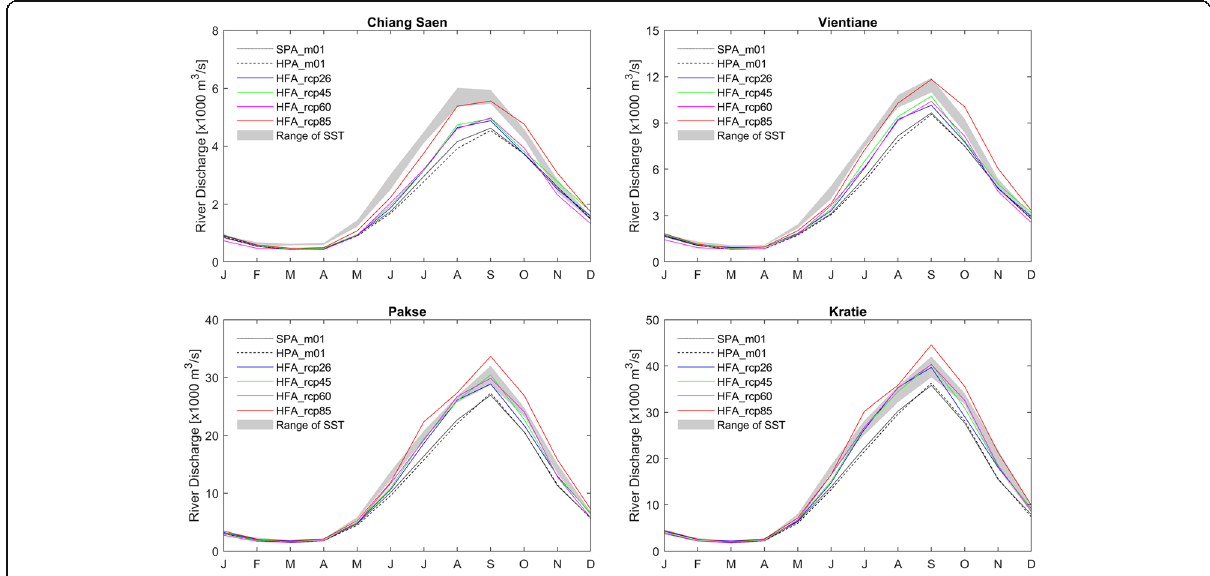
Fig. 6 Average monthly discharge of present and projected future climate experiments of RCP and SST scenarios